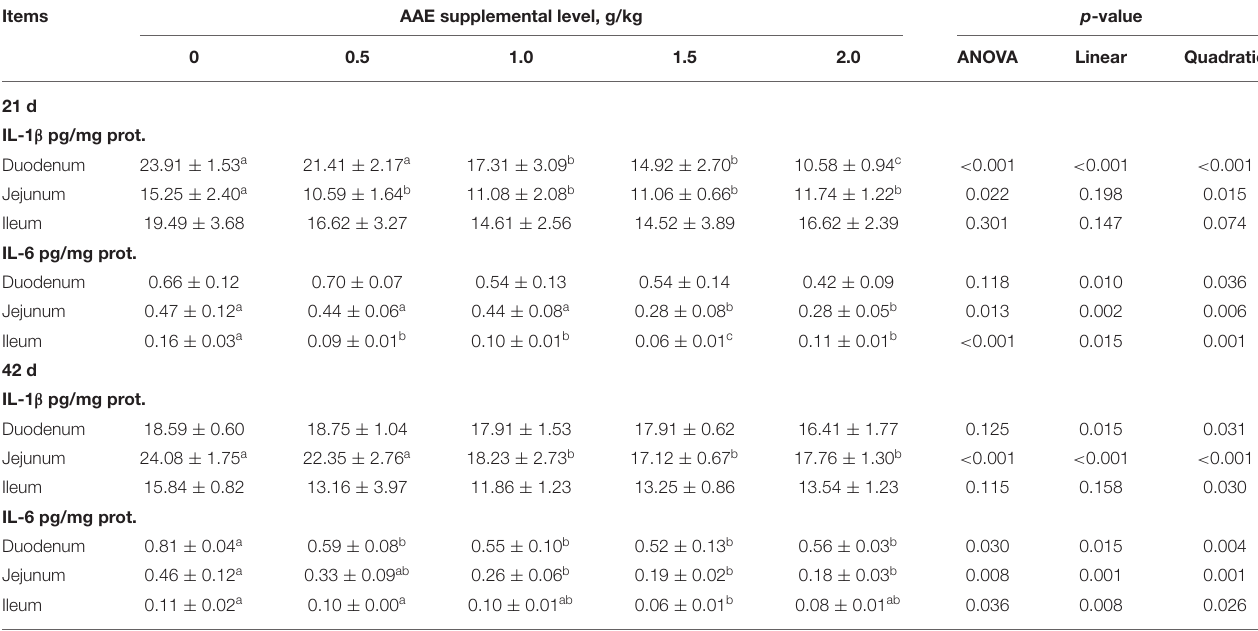
TABLE 3 | Effect of AAE on cytokine content in small intestine of broilers.